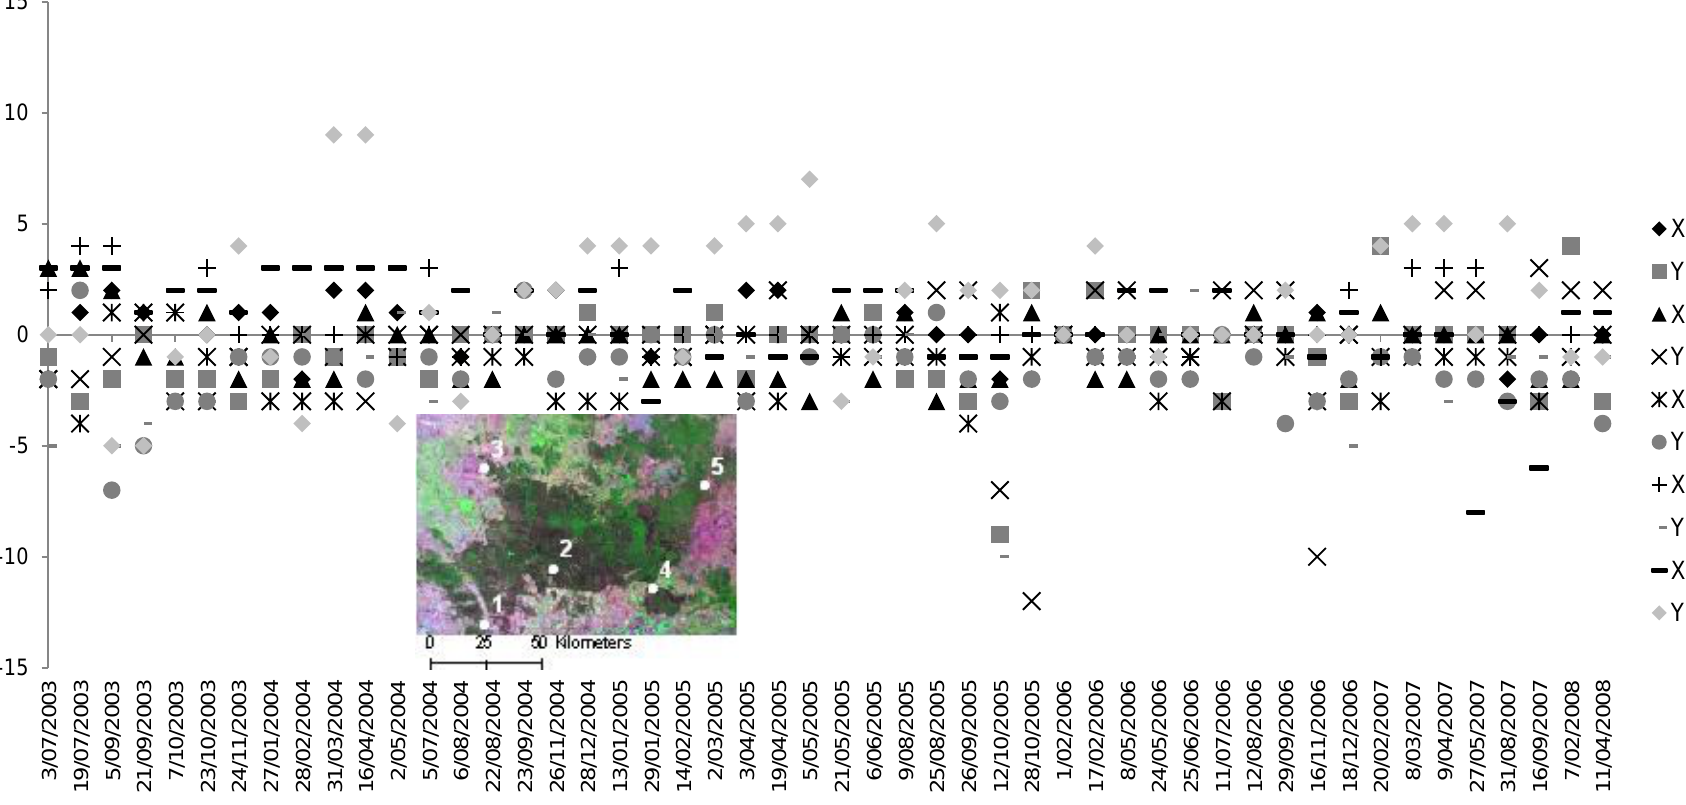
Figure 3. Evaluation of geometric consistency of the images used for developing LITS by common point comparison method. Y axis shows the deviation in X and Y coordinates of five different points (shown in image) in other images compared to reference images dated 2006/02/01. The symbols X1, Y1, X2, Y2 etc . represent the deviation of respective points. Only the images that were cloud free in all five points were plotted